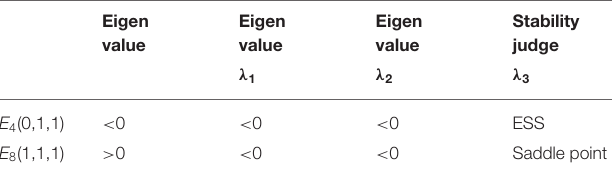
FIGURE 3 | Three-party dynamic evolution simulation with an initial value